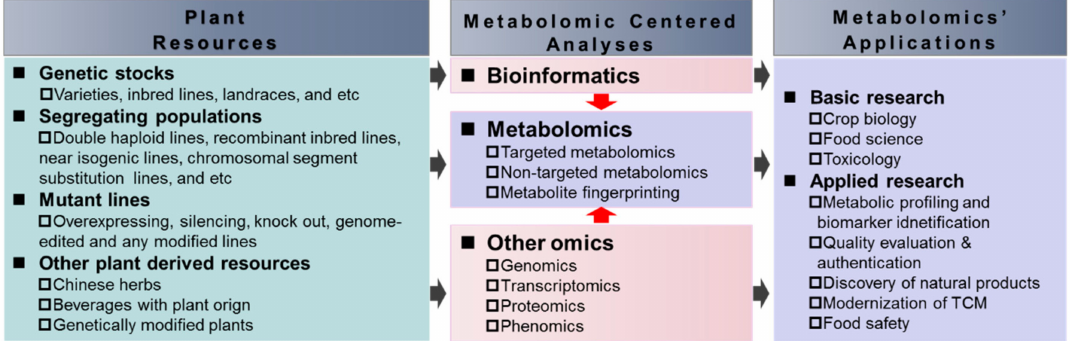
Figure 2. A schematic diagram showing the path of the applications of plant metabolomics in human nutrition and health promotion. TCM, traditional Chinese